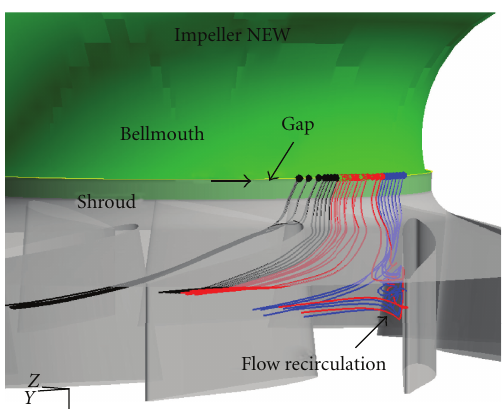
Figure 19: Streamlines initiating at the gap produce trailing-edge flow